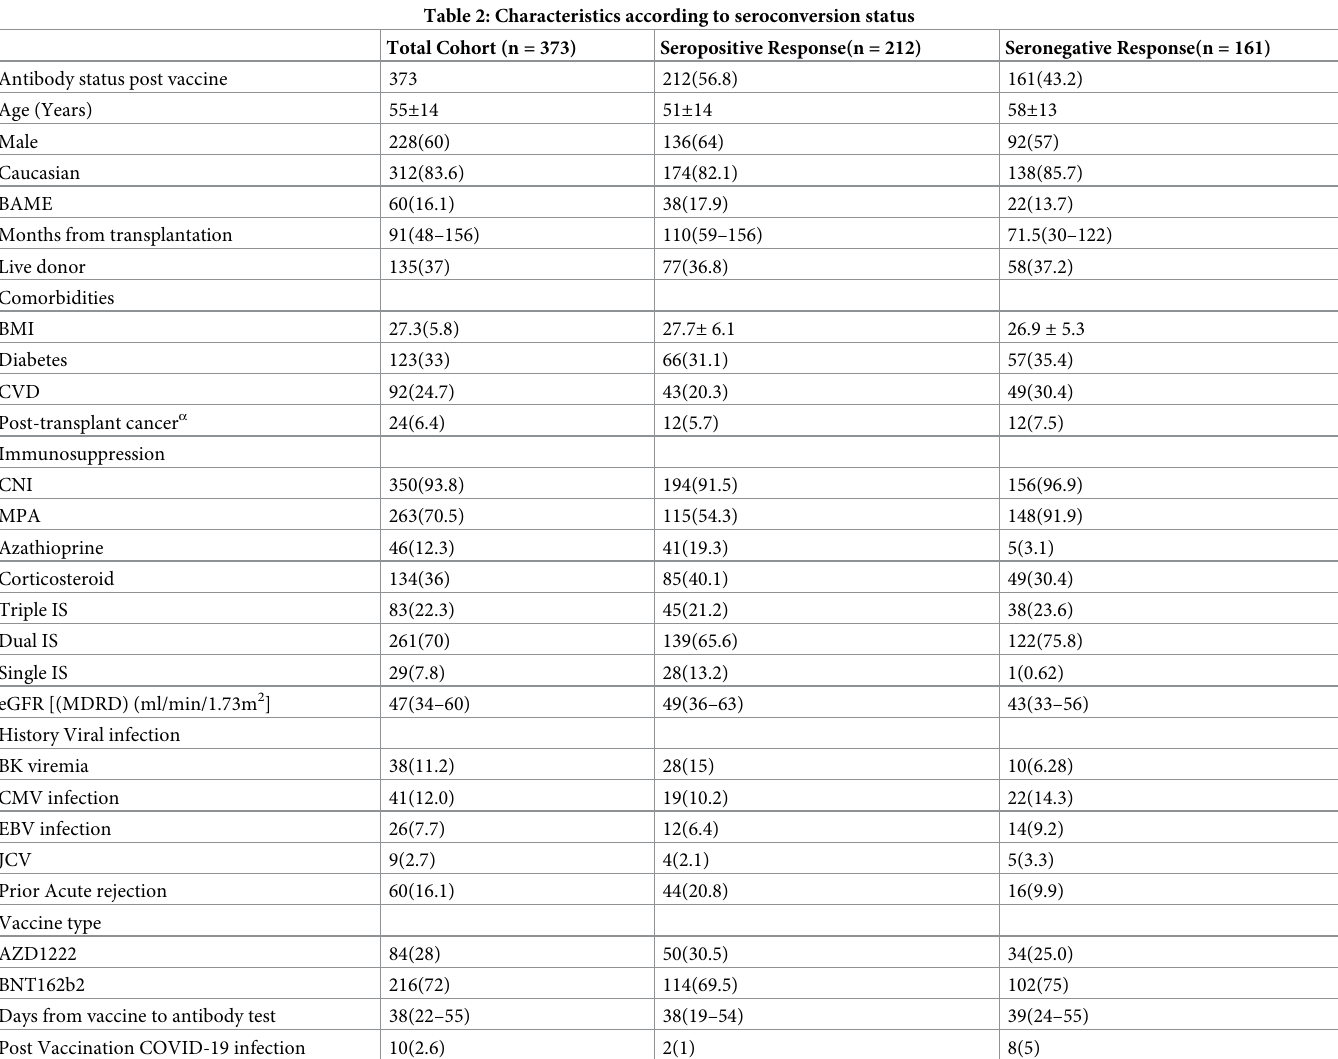
Table 2. Demographics, comorbidity and transplant characteristics of transplant recipients stratified by vaccine response. Table 2: Characteristics according to seroconversion